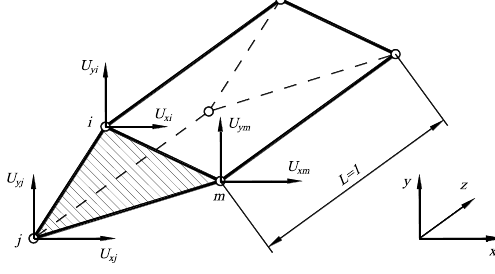
Fig. 3. Simplex element for a plane